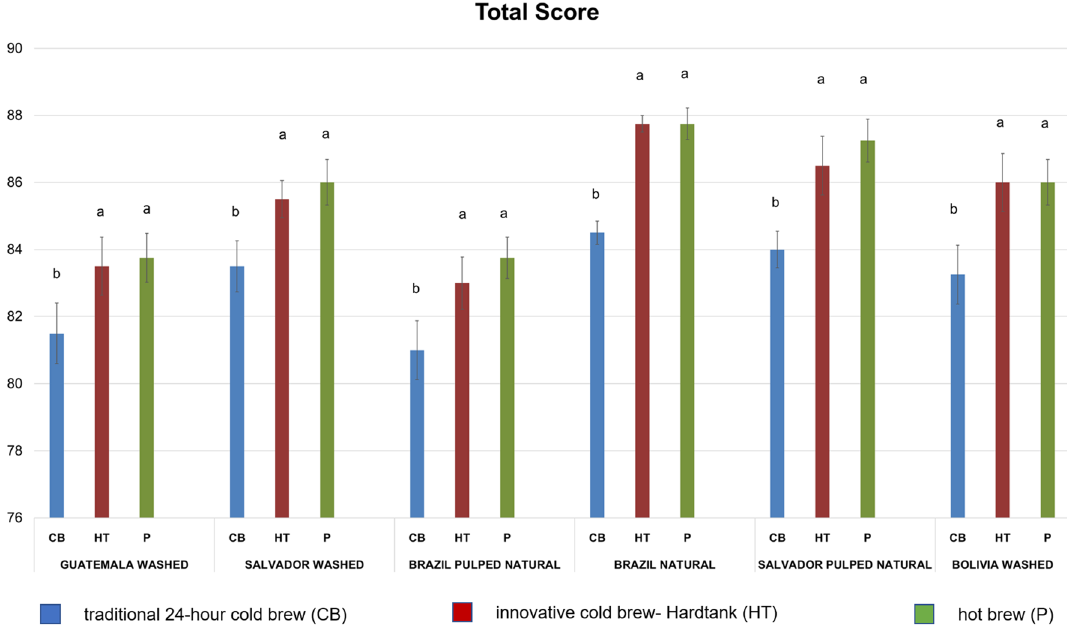
Figure 3. Comparison of total score of coffee samples. The superscripts a, b denote significant (p < 0.05) differences between Hardtank, traditional cold and hot brewing method within the same coffee sample. Mean value ± standard deviation, n = 10.